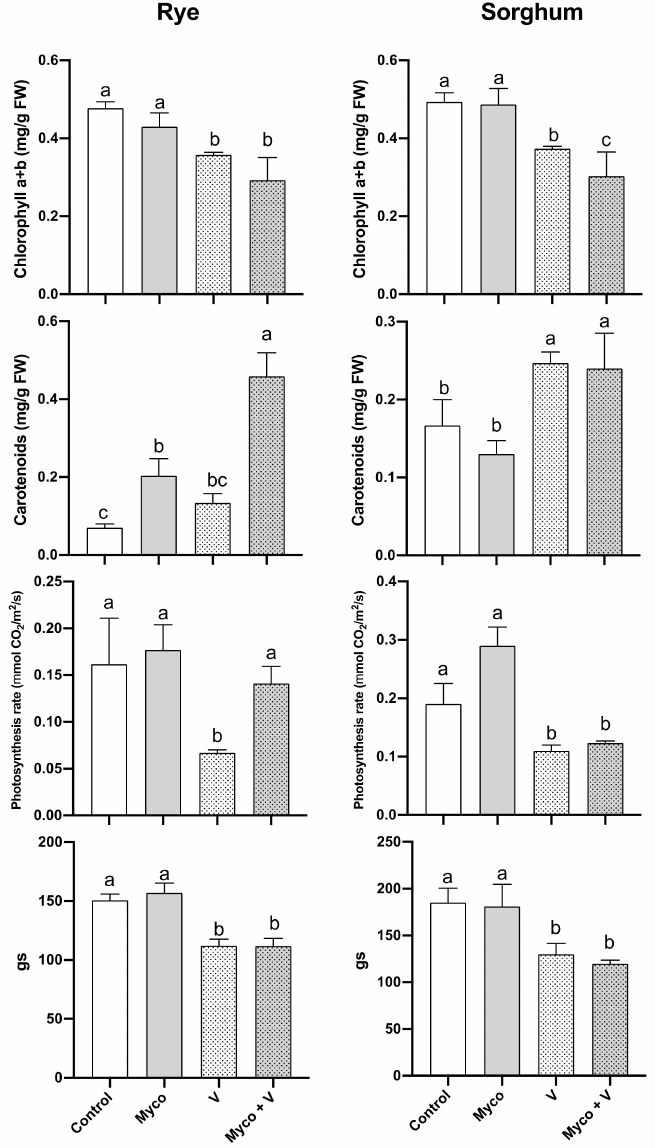
Figure 2. Changes in the photosynthetic parameters (total chlorophyll and carotenoid content, photosynthesis and gas exchange rates) of six-week-old rye and sorghum grown in soils with 0 or 350 mg/kg soil sodium vanadate and with or without soil enrichment with inoculum of the mycorrhiza Rhizophagus irregularis . Data are mean values ± SE ( n = 3). Data were statistically analyzed by one-way ANOVA followed by Tukey’s posthoc test for comparing the means. Different letters indicate statistically significant difference between means of the same plant species at significance level of at least ( p ≤